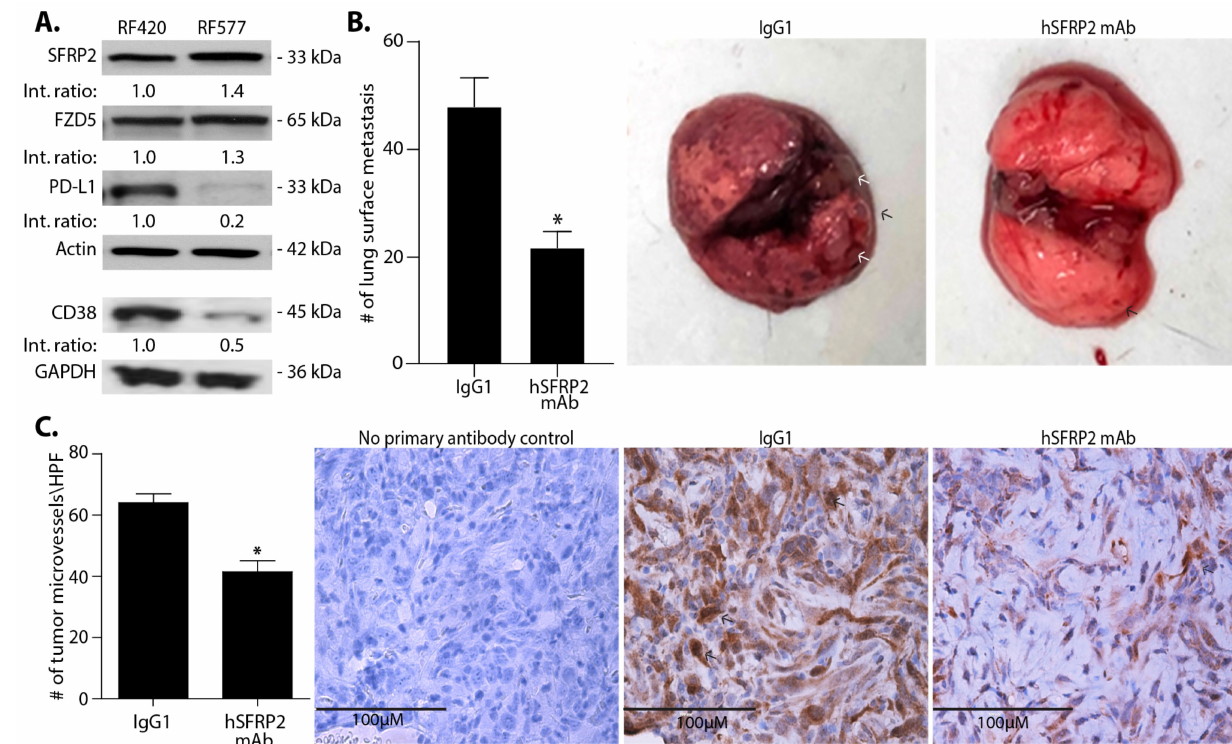
Figure 1. hSFRP2 mAb reduces metastatic osteosarcoma growth in vivo. ( A ) Characterization of two osteosarcoma cell lines: RF420 (left) and RF577 (right) by Western blot analysis probing for SFRP2, FZD5, CD38 and PD-L1 levels. Loading control: actin and GAPDH. Western blot shows SFRP2, FZD5, PD-L1 and CD38 proteins detected in both cell lines. PD-L1 and CD38 proteins were detected in RF420 with lower levels than in RF577. Int. ratio: intensity ratios listed below SFRP2, FZD5, PD-L1, and CD38 Western blots were calculated in RF577 cells after normalization to both the loading control (actin or GAPDH) and reference sample in RF420 cells (indicated by 1.00). ( B ) In vivo monotherapy with hSFRP2 mAb in RF420 OS lung metastasis model. Osteosarcoma RF420 cells were injected iv via the tail vein in C57BL/6 mice. Treatments with IgG1 control (4 mg/kg weekly) or hSFRP2 mAb (4 mg/kg every 3 days) started 8 days after tumor cell injection. After 21 days of treatment, animals were euthanized, lungs were resected and surface nodules were quantified. Left: quantification of lung metastases in IgG1-treated control mice ( n = 19) versus hSFRP2 mAb treated mice ( n = 22) (* p < 0.001). Middle: representative lungs from a mouse treated with IgG1 control with multiple OS tumor metastases (arrows). Right: representative lungs from a mouse treated with hSFRP2 mAb with minimal OS metastases ( C ) Angiogenesis of metastases analyzed on paraffin-embedded lungs that underwent immunohistochemistry with antibody to CD31. Left: quantification of microvessel density measured on microphotographs of metastases from CD31-stained tissues, showing a reduction in hSFRP2 mAb-treated tumors ( n = 10, * p ≤ 0.001). Right: representative images of CD31-stained sections of lung tumors with negative control, IgG1 control-treated, and hSFRP2 mAb-treated. HPF: High Power Field. Scale bar: 100 µ